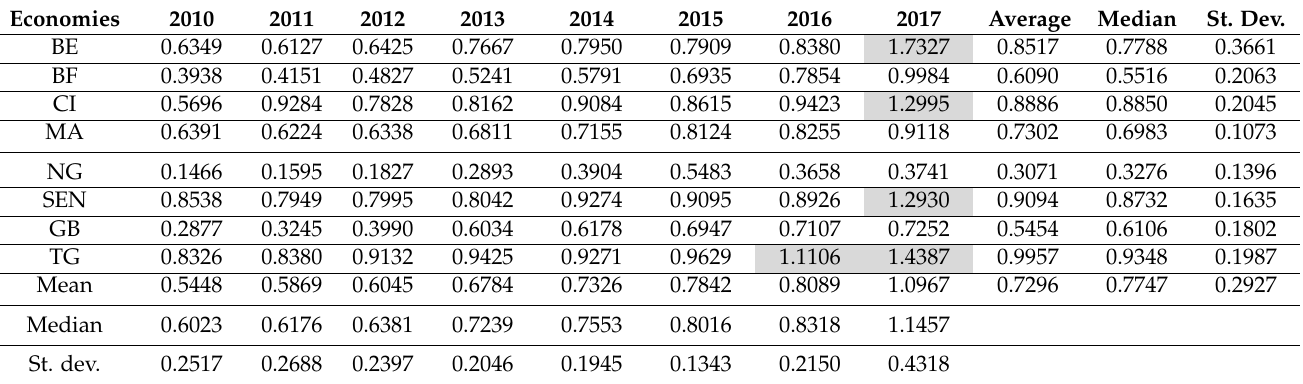
Table 5. AS–SE—Descriptive analysis.